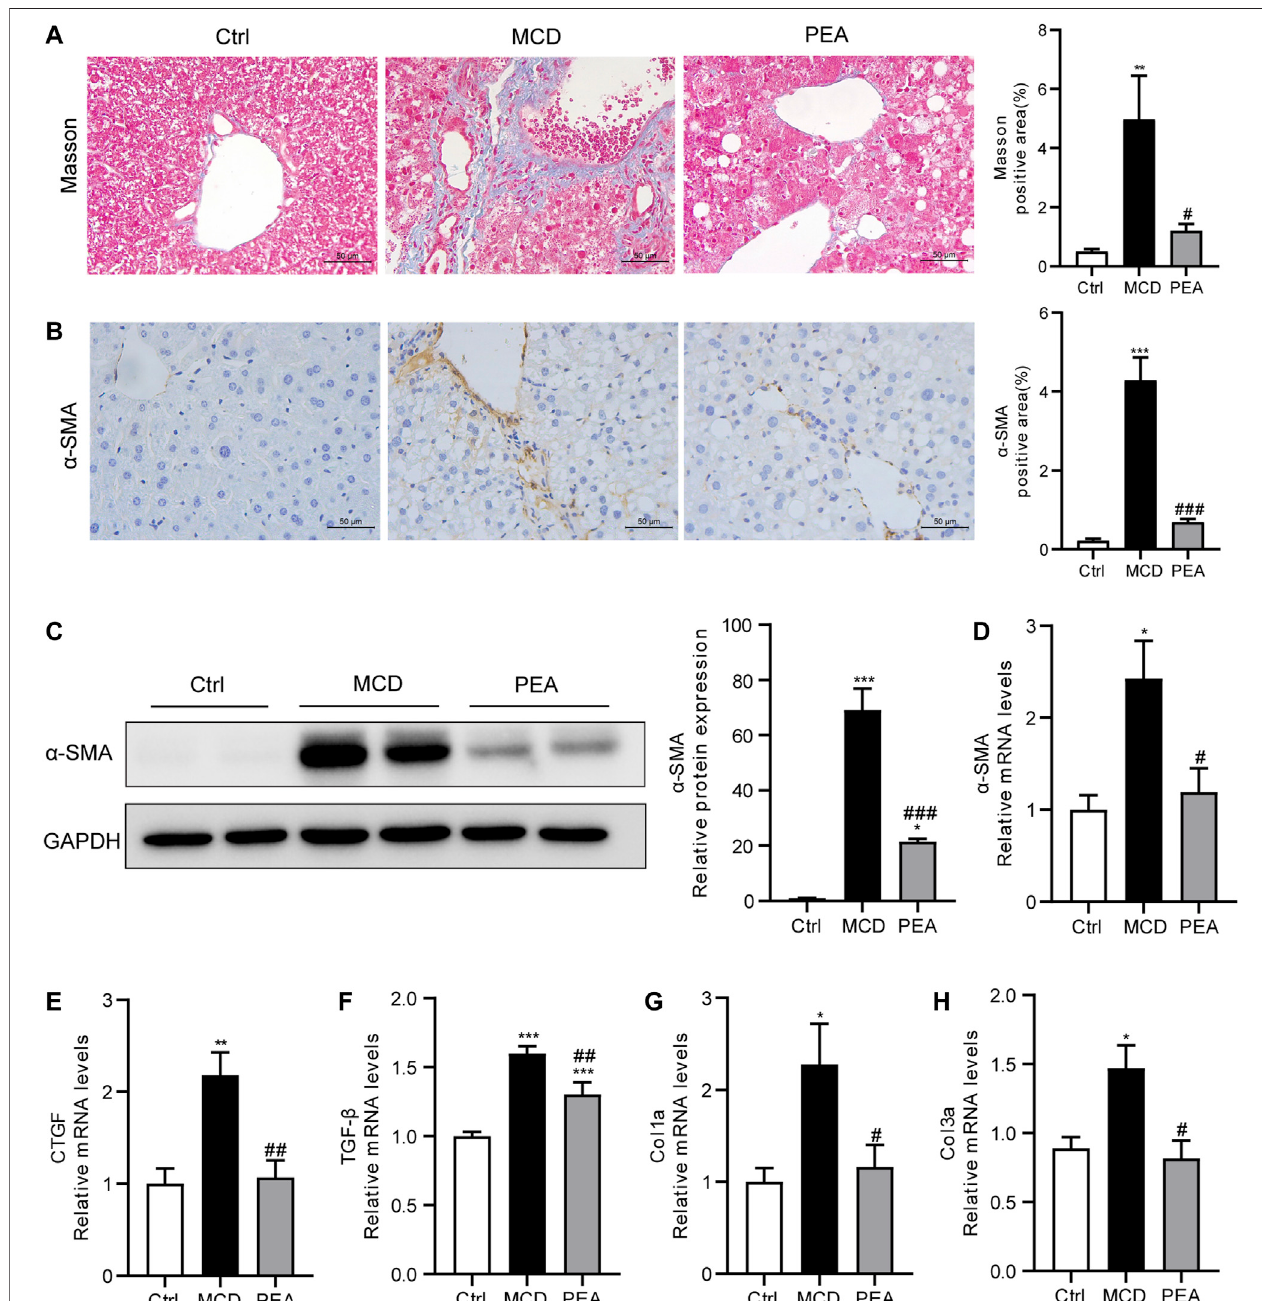
FIGURE 7 | PEA attenuated hepatic fi brosis in mice who received MCD diet feeding. (A) Histological analysis of fi brosis in the liver via Masson ’ s trichrome staining ( × 400). (B) Hepaticstellatecellsactivationwasexaminedthroughstainingof α -SMAintheliver( × 400). (C) Hepatic α -SMAproteinlevelsdeterminedbywesternblot. (D) α -SMA, (E) CTGF, (F) TGF- β , (G) Col1a, and (H) Col3a mRNA expression in liver. Ctrl: the mice treated with standard diet; MCD: the mice treated with MCD diet; PEA: the mice treated with MCD diet and PEA. Values were expressed as the mean ± SEM, n (cid:1) 6 – 8 for each group. * p < 0.05, ** p < 0.01, *** p < 0.001 versus the Ctrl group; # p < 0.05, ## p < 0.01, ### p < 0.001 versus the MCD